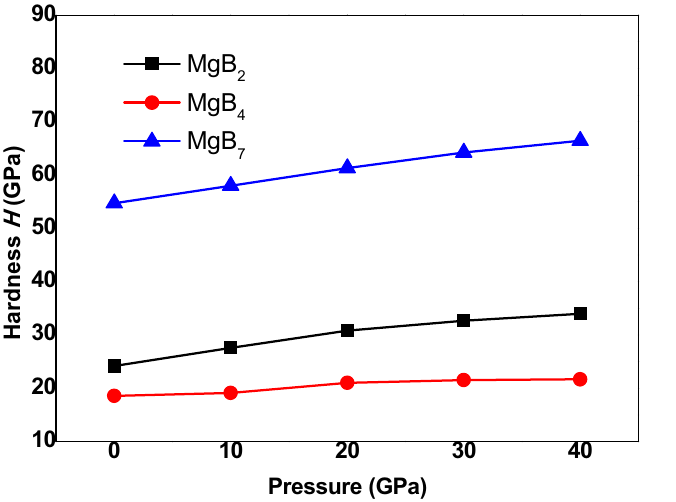
Figure 7. Variation of micro-hardness at various pressures.